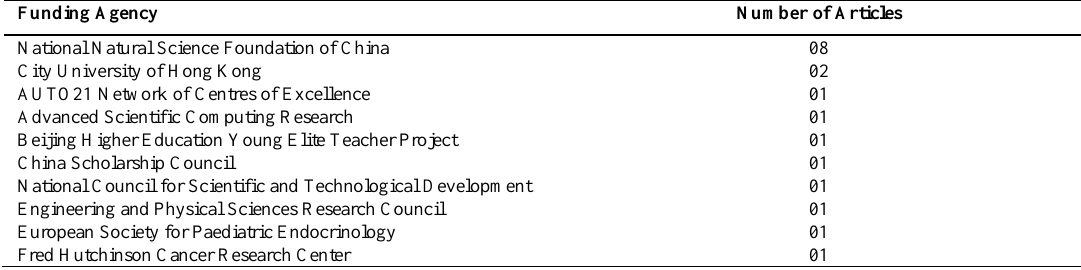
Table 7. Funding agencies: intellectual capital and operational excellence